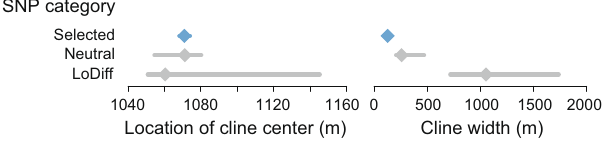
Fig. 4 Cline parameter estimates for different SNP categories. Estimation of the geographic location of the cline center and the width of the cline by cline modeling for the selected SNPs (blue; AFD ≥ 0.97 in the L1-S7 comparison), and the neutral (AFD near the genome-wide median) and loDiff (AFD near half the median) SNPs (gray). The diamonds indicate the median value across the 50 independent SNPs in each marker category, and the bars give the associated bootstrap 95% compatibility intervals. Source data are provided as a Source Data fi